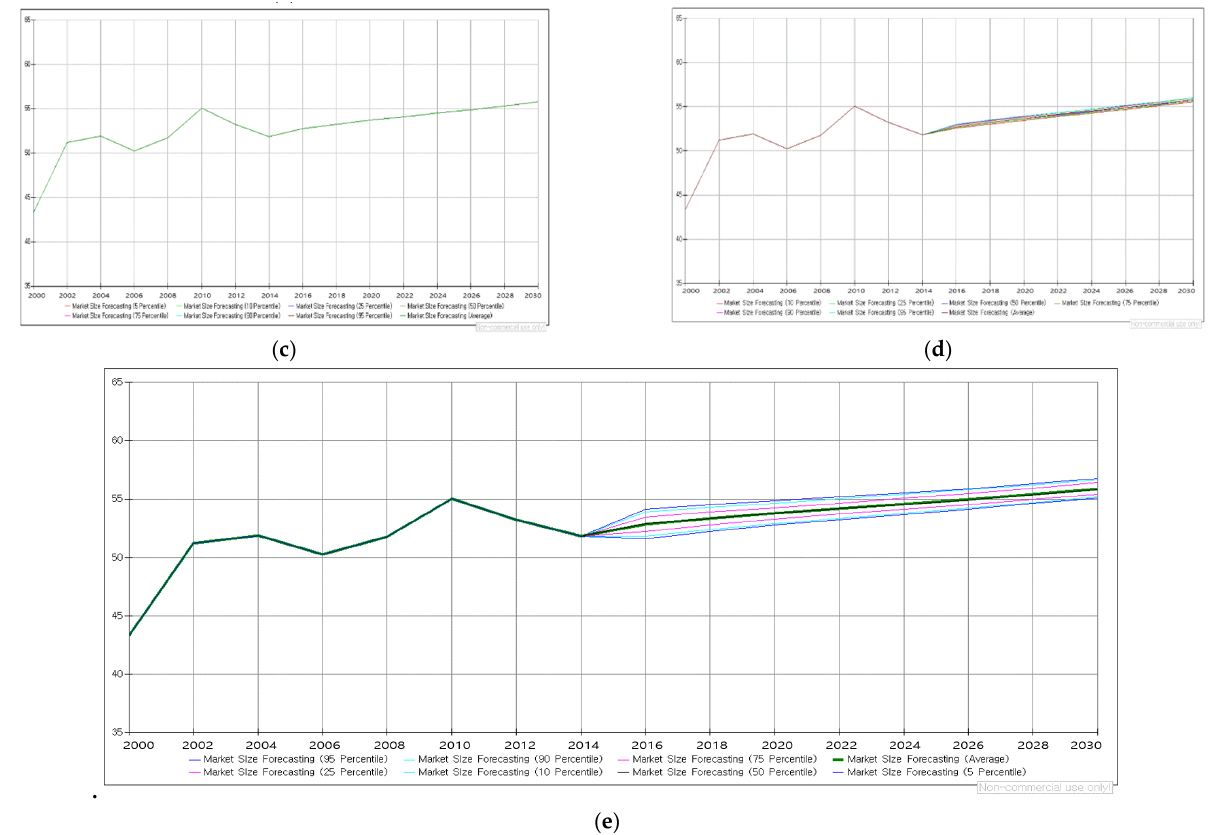
Figure 8. Analysis of new construction market sensitivity in residential sector. ( a ) Interest rate; ( b ) percentage of construction stock to GDP; ( c ) facilities durable years; ( d ) market regulation; ( e ) multivariate sensitivity.